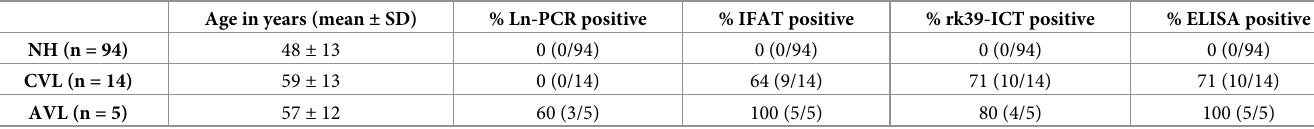
Table 1. Mean age of subjects and percentages with positive Ln-PCR, IFAT, rk39-ICT and ELISA tests. Age in years (mean ± SD)